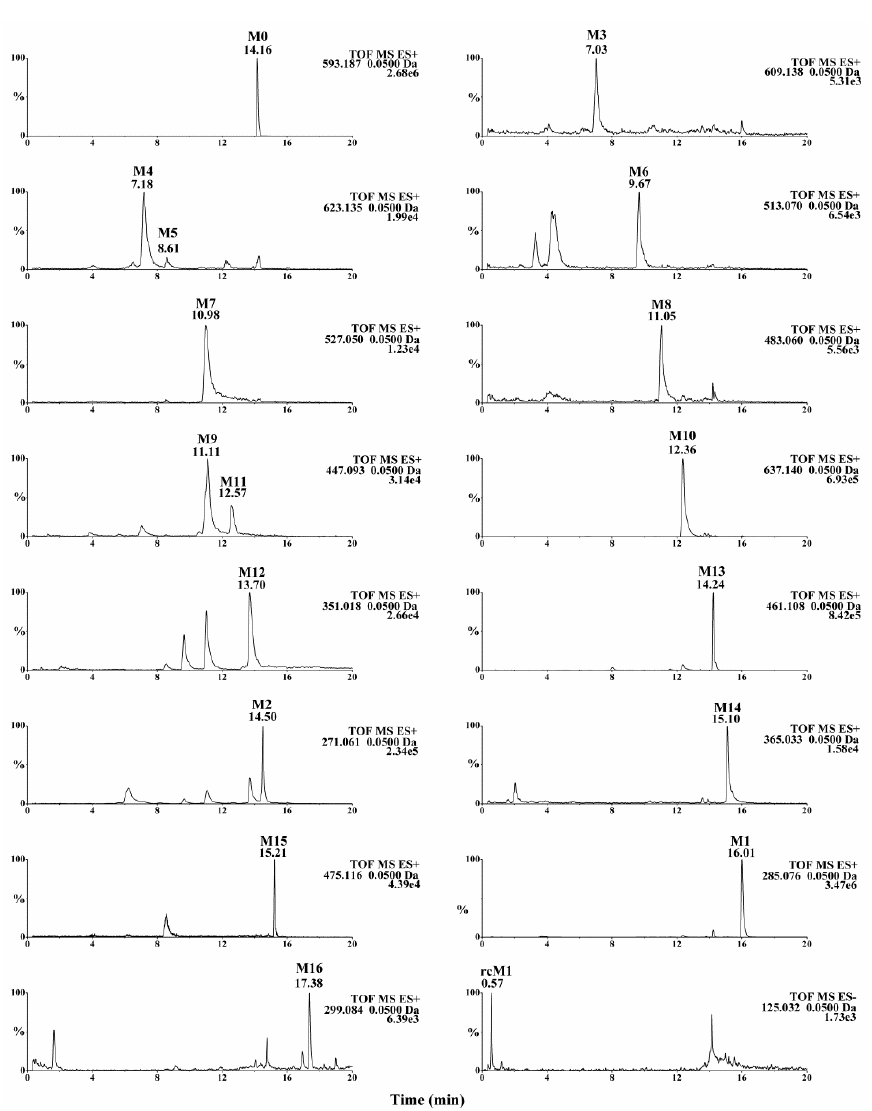
Figure 2. Extracted ion chromatograms (EICs) of linarin metabolites in rat biosamples. EICs for M0 and M16 were obtained from feces samples. EICs for M1-M15 were obtained from urine samples. EIC for rcM1 was obtained from bile sample. The compound abbreviations are explained in Table 1. EICs of linarin metabolites in blank rat biosamples were showed in Figure